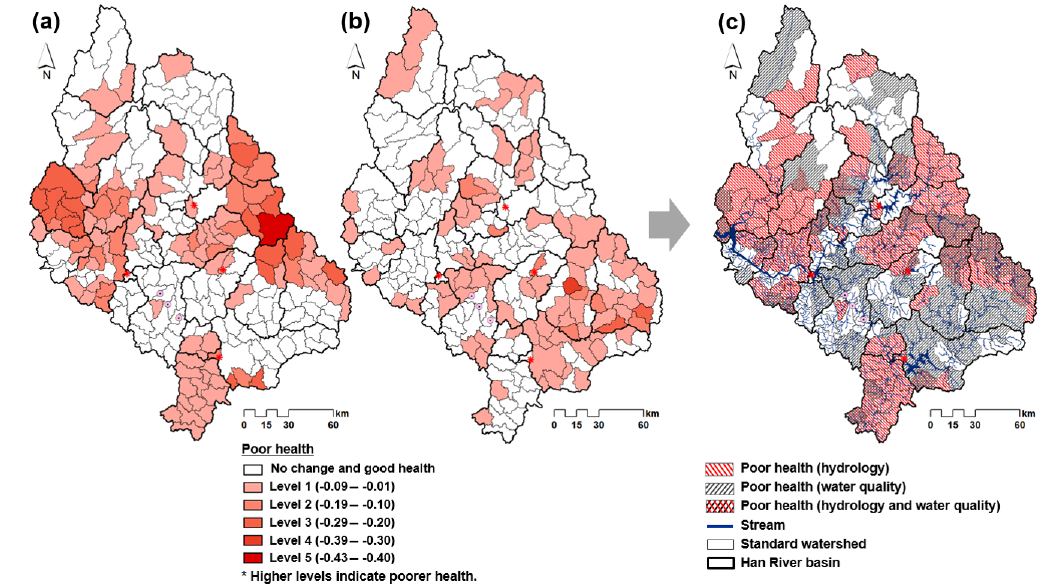
Figure 11. Poor watershed health as revealed by the (a) hydrology, (b) water-quality, and (c) overlay results.